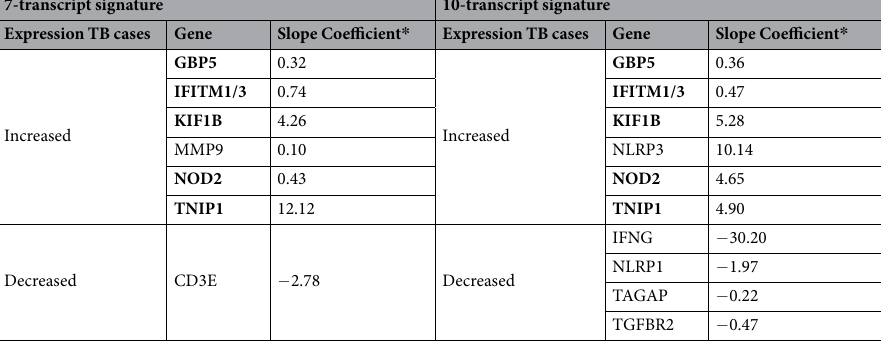
Table 2. Gene expression and slope coefficients for each biomarker for the identified signatures. The 5 genes common for both signatures are denoted in bold-face. * Slope coefficients are scaled-up by a factor of